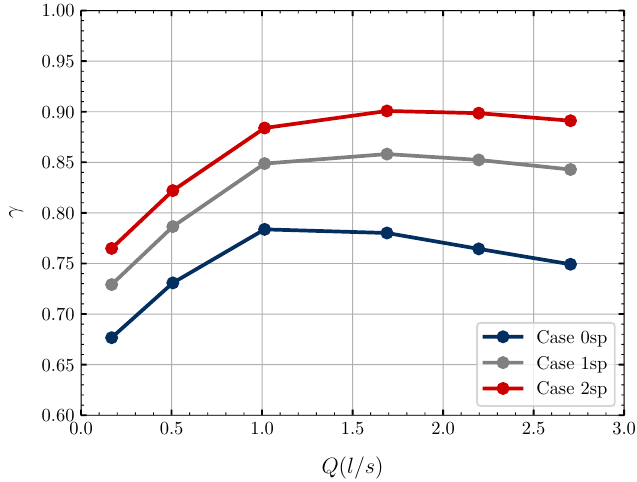
Figure 14. Slip factor as a function of the flow